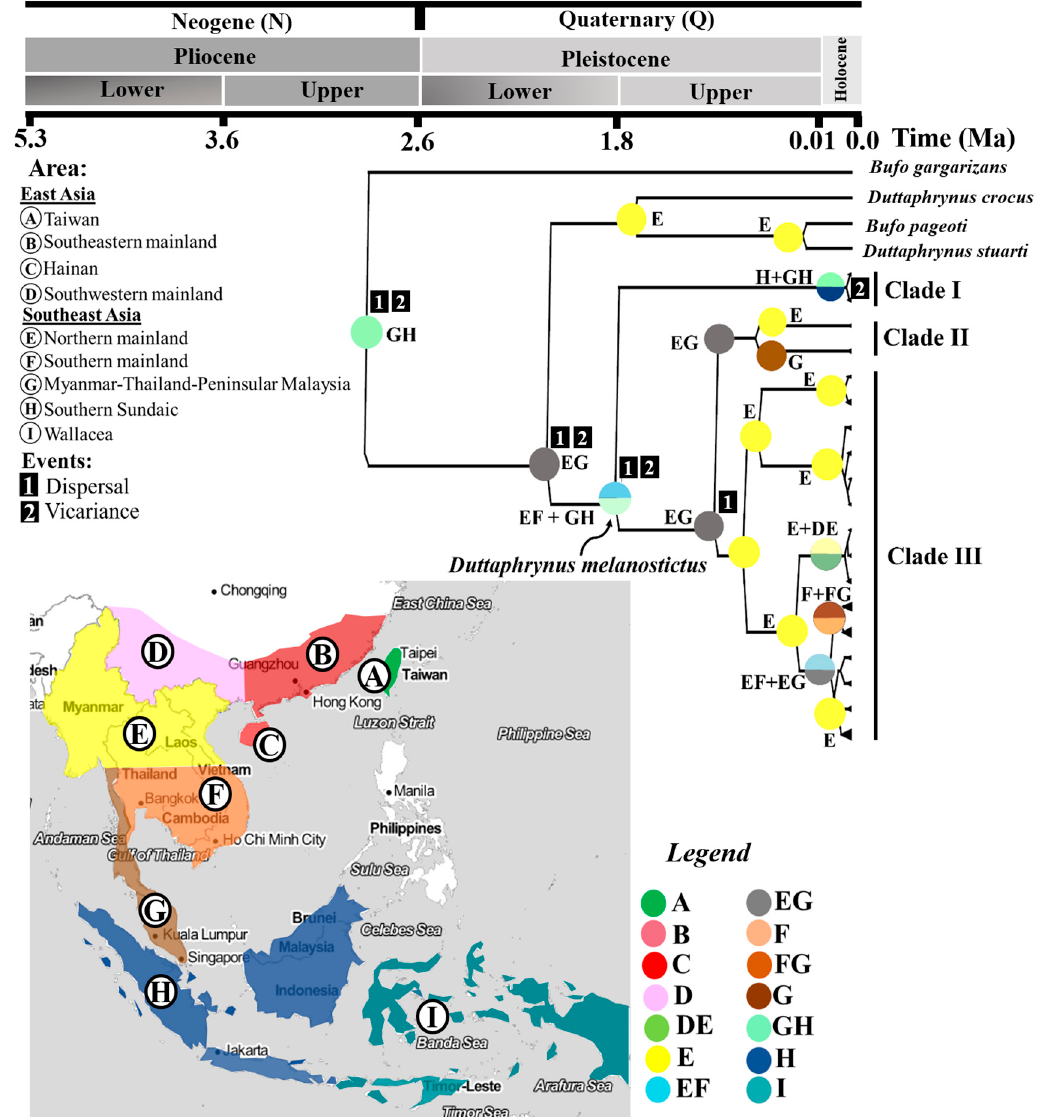
Figure 3. Ancestral range reconstruction and Statistical Dispersal Vicariance Analysis (S-DIVA) with dating estimates on clades divergence and inferred from mtDNA tRNAGly ND3 fragment for 10 populations of 303 individuals Duttaphrynus melanostictus . A–H represent populations based on colour-coded geographical areas. EG (E + G), FG (F + G) and GH (G + H) represent the combined range of distribution for two areas. Missing geographical region in the tree nodes indicates anthropogenic introduction of this species in that part of the range.